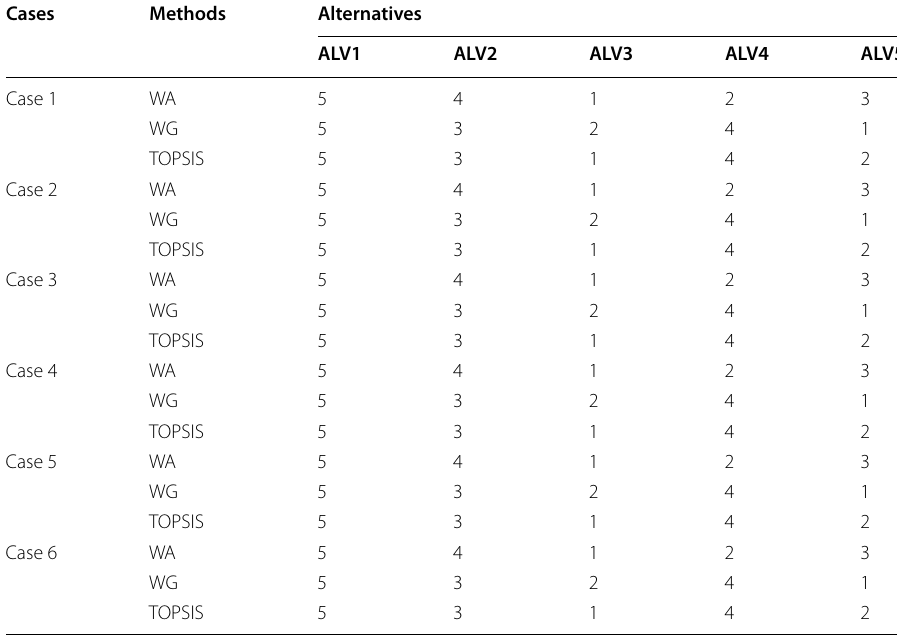
Table 15 Sensitivity analysis results based on q-ROF M-SWARA